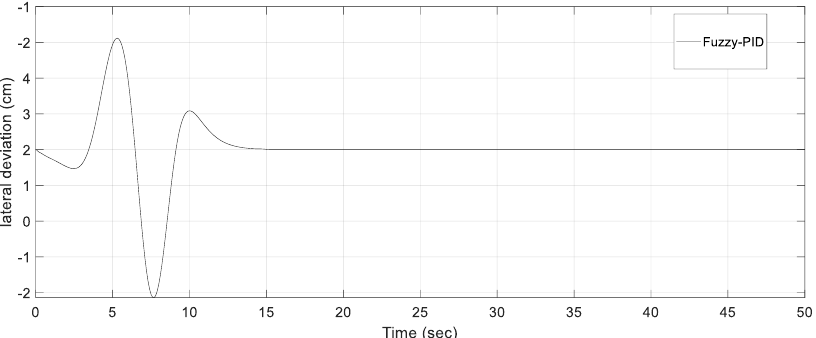
Figure 5. Performance of the fuzzy-PID controller.